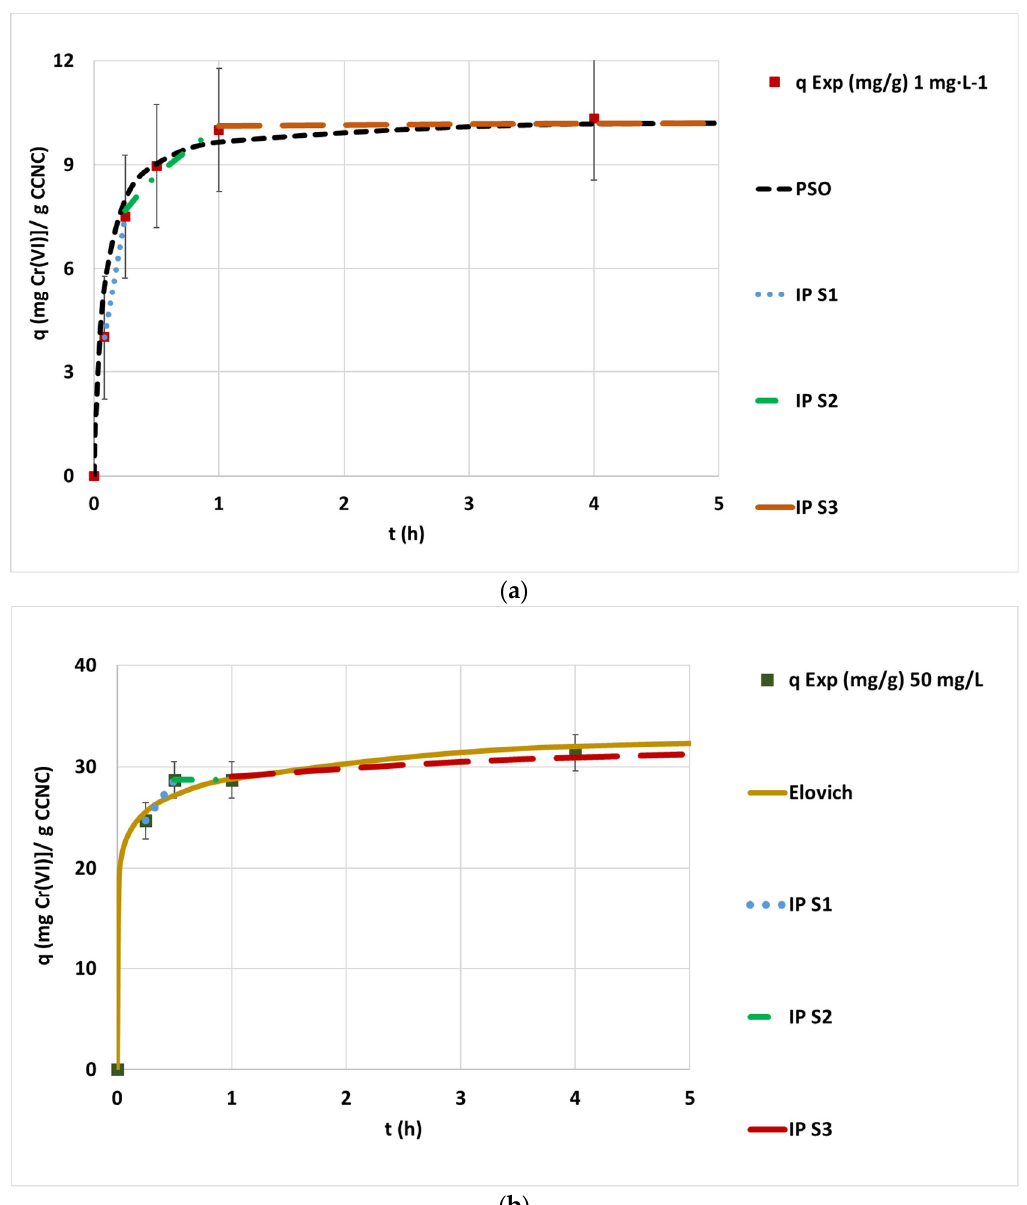
Figure 6. ( a ) Evolution of the kinetic adsorption experiment at 1 mg·L −1 of initial chromium concentration under pH 3, room temperature and 100 mg·L −1 of CCNC dosage and 5 h of contact time and the kinetic fitting of the PSO and IP models; ( b ) 50 mg·L −1 of initial concentrations under the same experimental conditions and the kinetic fitting of the Elovich and IP models.